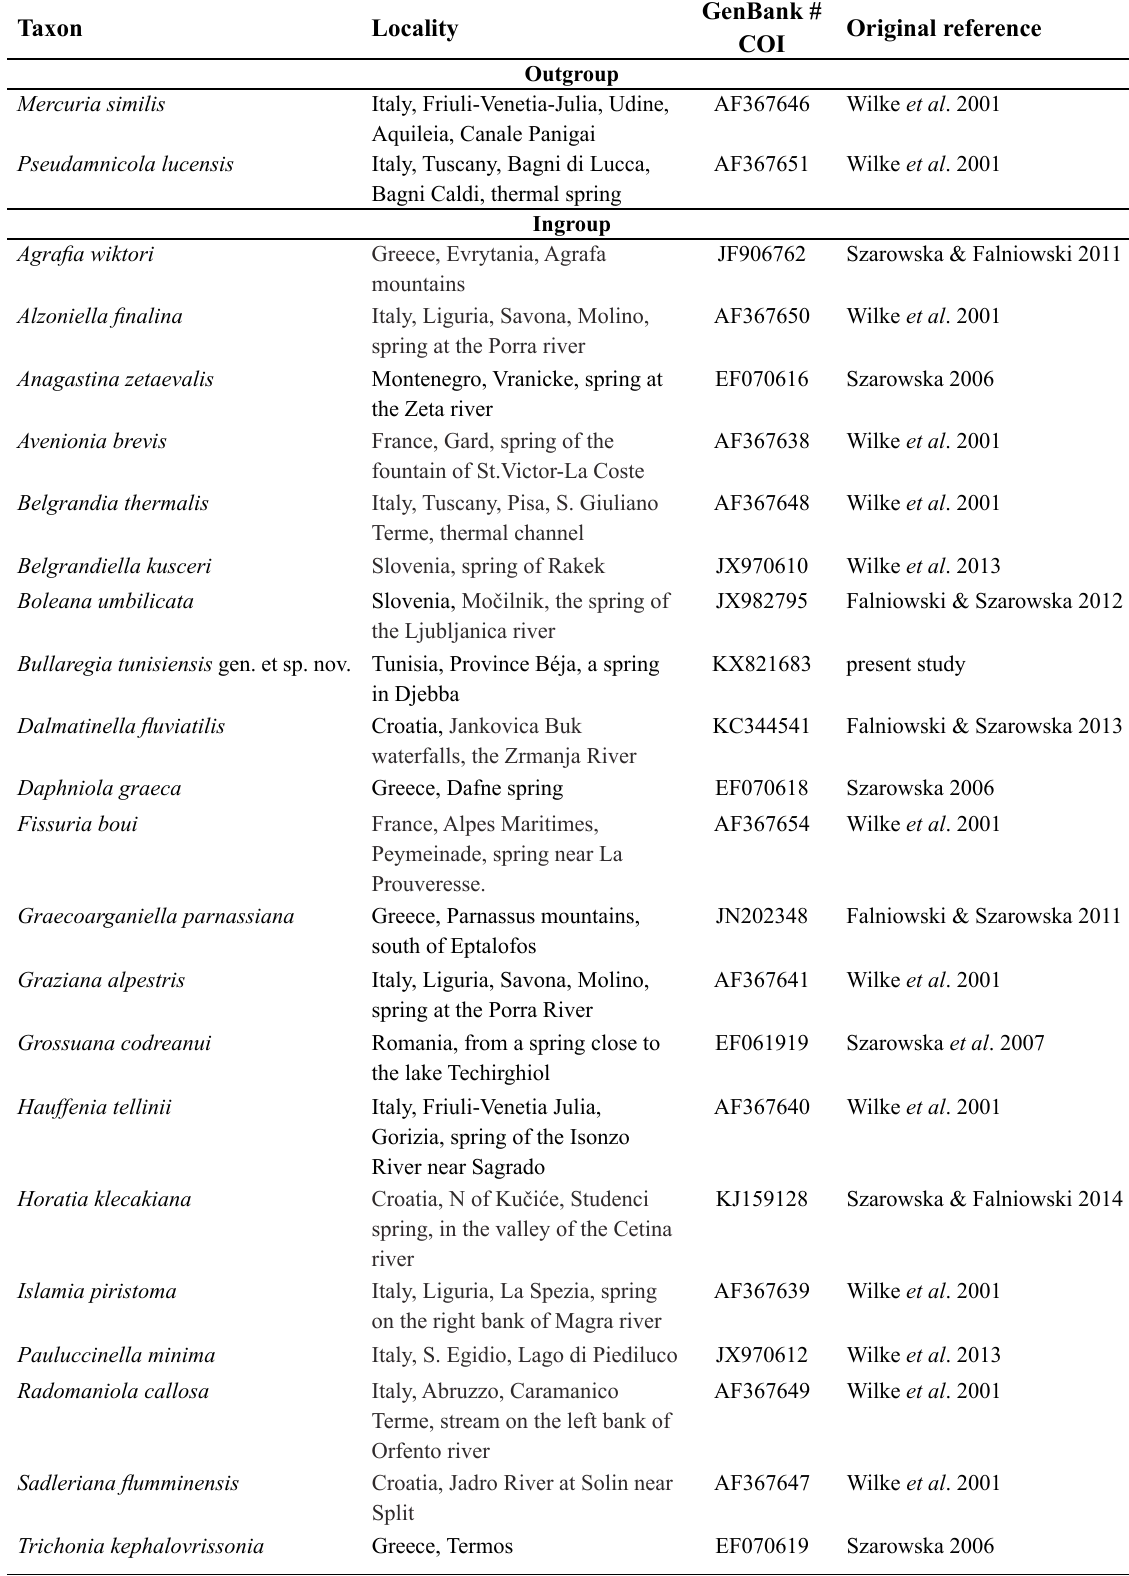
Table 1. Taxa included in the molecular analyses with their corresponding locality names, GenBank accession numbers and original